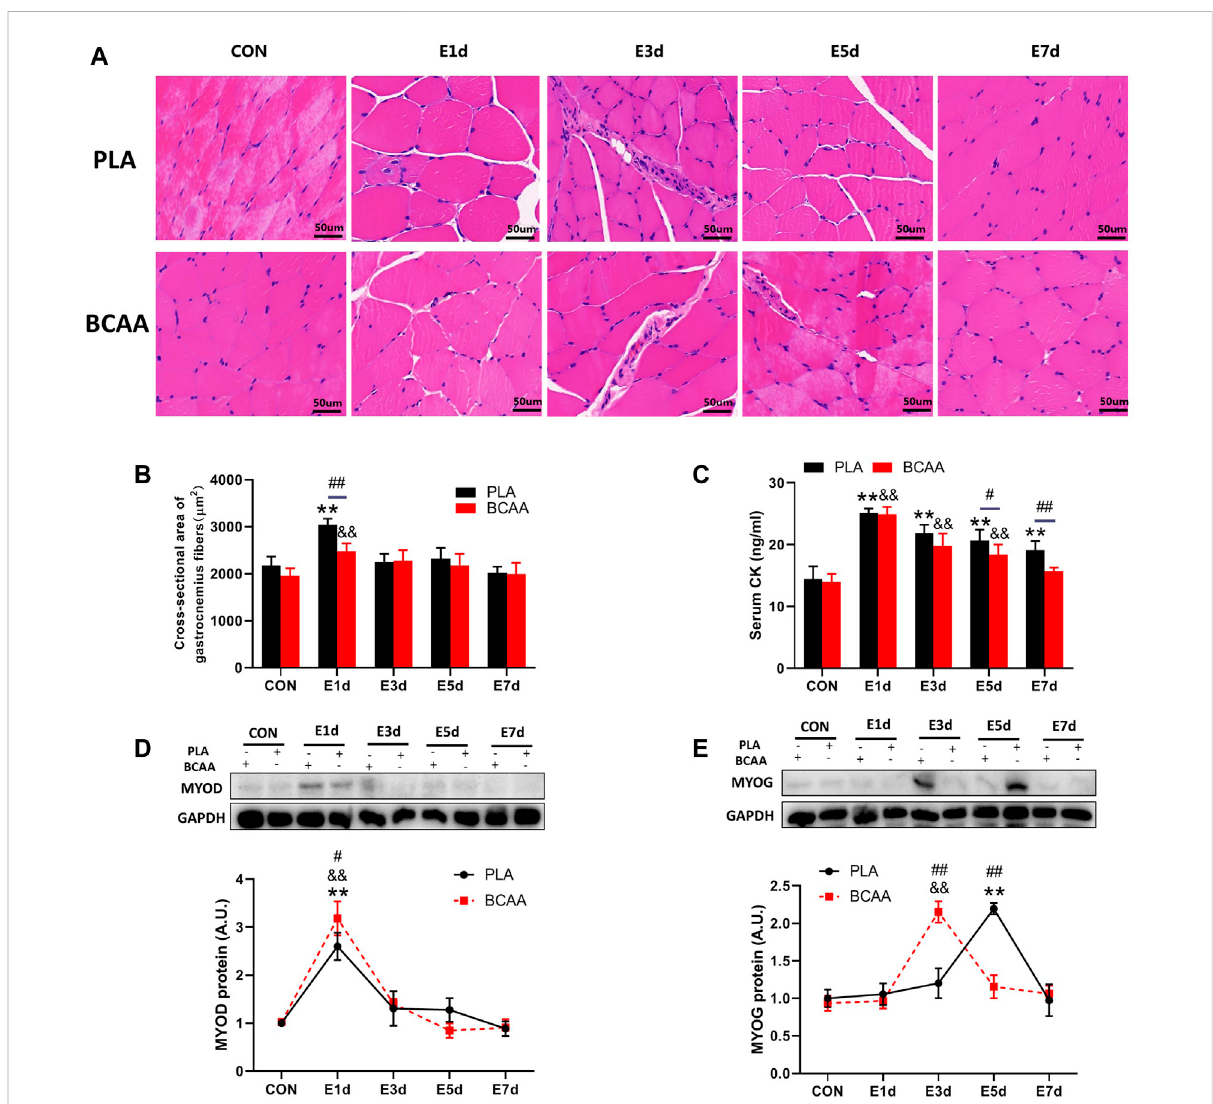
FIGURE 1 Branched-chain amino acids (BCAAs) promote the repair of exercise-induced muscle damage (EIMD). (A) The effect of BCAAs on the microstructure of gastrocnemius muscle in rats with EIMD as revealed by HE staining (Scale Bar = 50 um). (B) The effect of BCAAs on the cross- sectional area of gastrocnemius fi bers in rats with EIMD. (C) The effect of BCAAs on serum CK levels in rats with EIMD. (D,E) The effect of BCAAs on the proliferation (MYOD) and differentiation (MYOG) of the gastrocnemius satellite cells (SCs) in rats with EIMD. Data are presented as mean ± SEM. * p < 0.05, ** p < 0.05 vs. PLA CON; & p < 0.05, && p < 0.05 vs. BCAA CON; # p < 0.05, ## p < 0.05 between PLA and